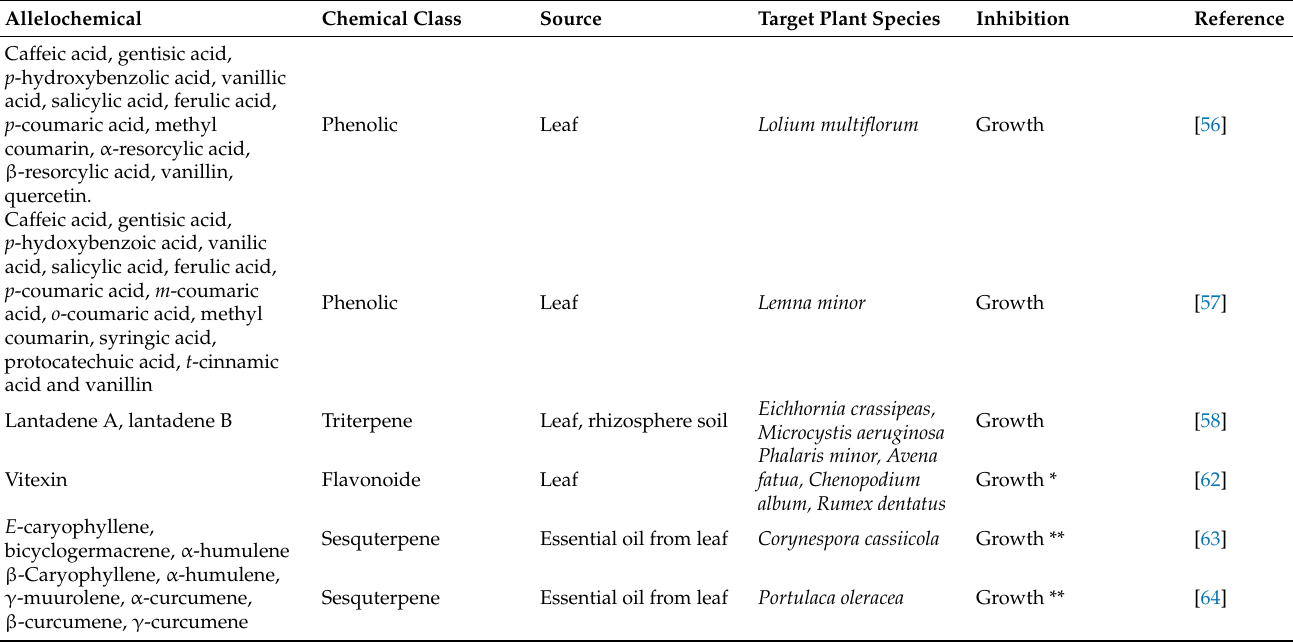
Table 2. Allelochemicals of Lantana camara and target plant species for their